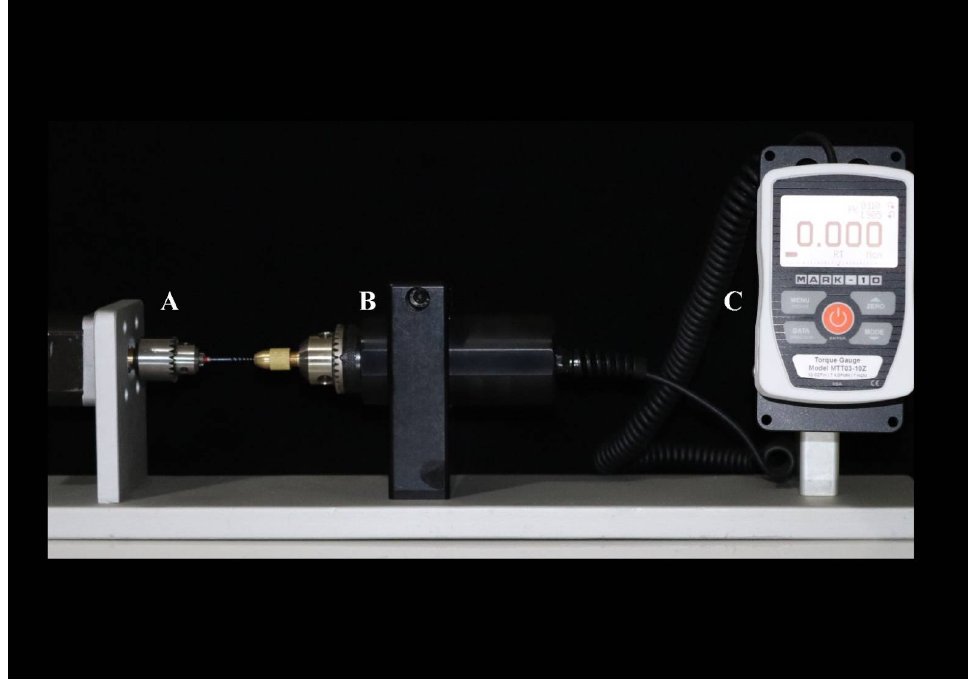
Figure 2. Torsional strength test setting: ( A ) file clip, ( B ) torsion device, and ( C ) control panel.